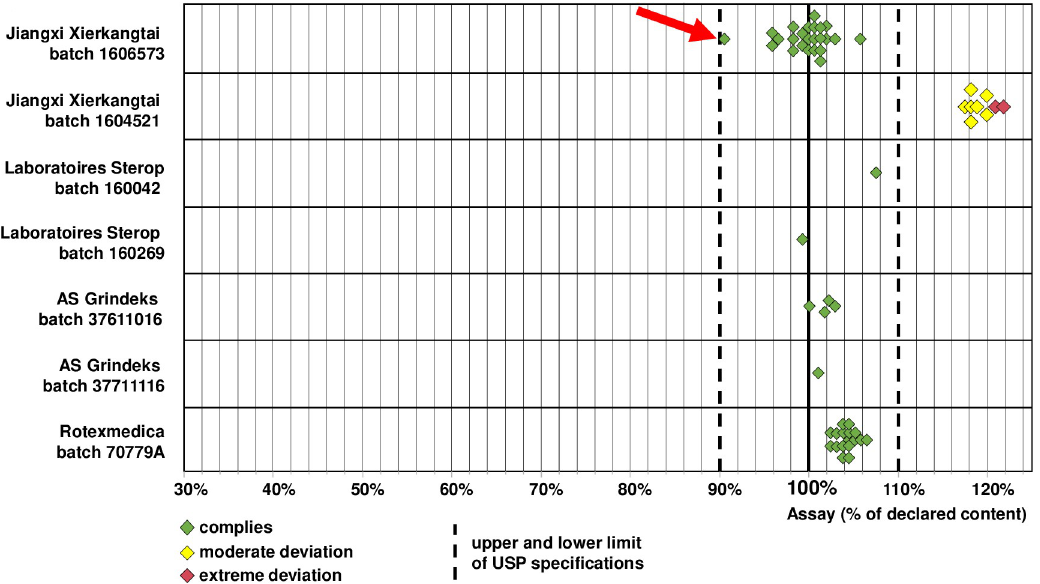
Fig 3. Content of oxytocin determined in each of the investigated samples. The arrow marks a sample with deviating content of the active pharmaceutical ingredient oxytocin and of the preservative benzyl alcohol (see main text and Fig 4).